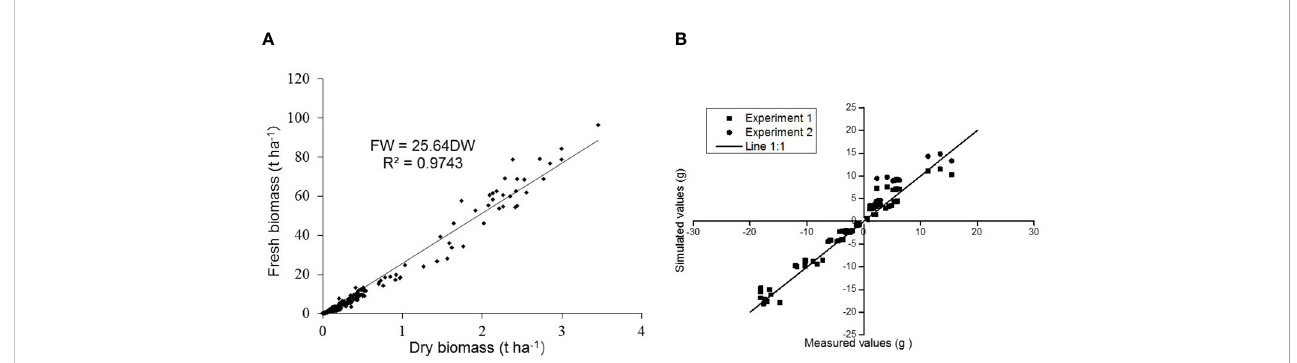
FIGURE 7 (A) The relationship between FW and DW under different N application rates of three experiments in pakchoi and (B) measured (x-axis) and simulated (y- axis) values of aboveground pakchoi biomass for the validation of the N requirement model. R 2 = the correlation coef fi cient of FW and the DW values and FW calculated by using Equation 13.